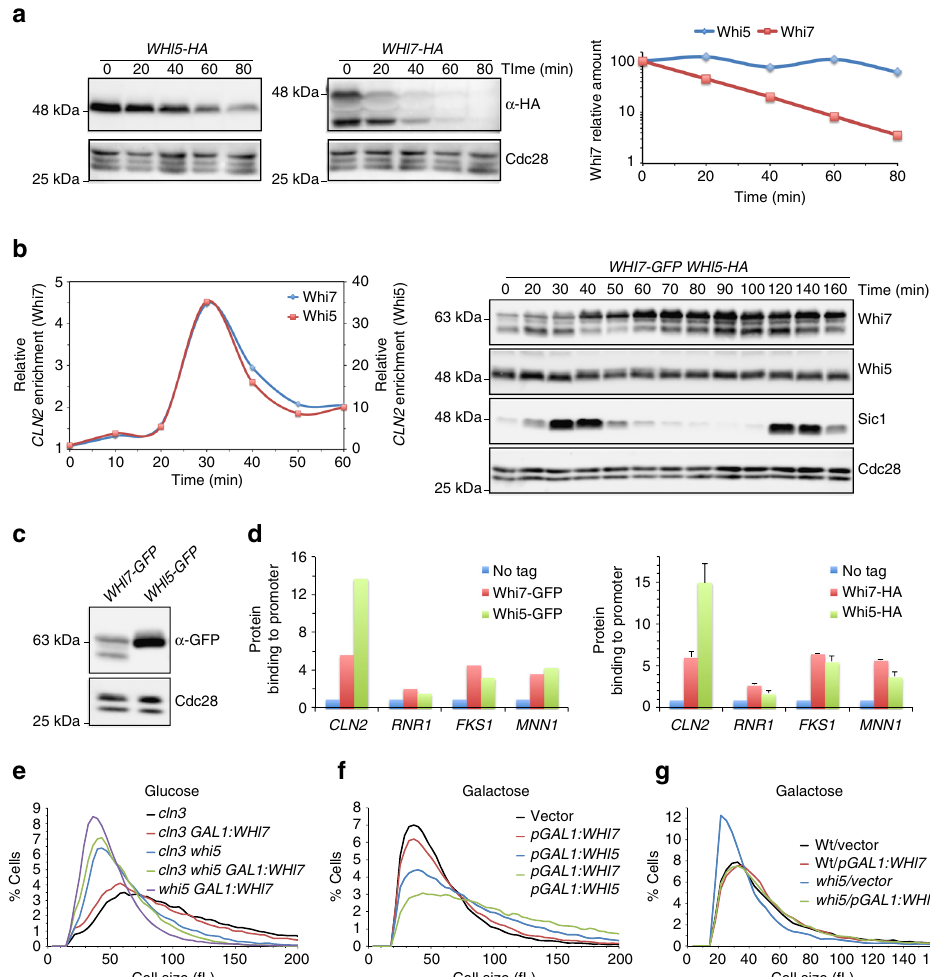
Fig. 7 Comparative analysis of Whi7 and Whi5 proteins. a Protein stability in WHI5-HA (JCY734) and WHI7-HA (JCY1728) cells was analyzed as described in Fig. 2. b Exponentially growing cultures of cdc15 SIC1-myc WHI5-HA WHI7-GFP (JCY1912) were arrested in telophase by incubation for 3 h at 37 °C. After release from the arrest, Whi5 and Whi7 binding to CLN2 promoter were investigated by ChIP assays. Western blot shows Whi5, Whi7, Sic1, and Cdc28 (as loading control). Cell cycle progression was monitored by the oscillations of Sic1 and bud emergence that indicated execution of Start at 40 min sample. c Analysis of protein level in wild-type cells expressing a GFP-tagged Whi7 (JCY1746) or Whi5 (JCY2009) protein. d Whi7 and Whi5 association to the indicated gene promoters was analyzed by ChIP assay in GAL1:CLN3 cln1 cln2 cells expressing either Whi7-GFP (JCY2008) or Whi5-GFP (JCY2007) 30 min after release from the G1 arrest ( left panel ), and in exponentially growing cultures of wild-type cells expressing either Whi7-HA (pWHI7-HA plasmid) or Whi5-HA (JCY1346) ( right panel ; values are the mean and s.d. derived from three experiments). e Cell size distribution in cultures on YPD medium ( GAL1 promoter repressed to mimic whi7 mutation) of cln3 (MT244), cln3 whi5 (JCY1875), cln3 GAL1:WHI7 (JCY1883), cln3 whi5 GAL1:WHI7 (JCY1921), and whi5 GAL1:WHI7 (JCY1885) mutant strains. f Cell size distribution in cultures on SC-Gal medium of the wild-type (W303) strain transformed with either the pGAL1:WHI5, pGAL1:WHI7, both plasmids or the corresponding control vectors. g Cell size distribution in cultures on SC-Gal medium of the wild-type (W303) and whi5 mutant (JCY1874) strains transformed with the pGAL1:WHI7 plasmid or a control